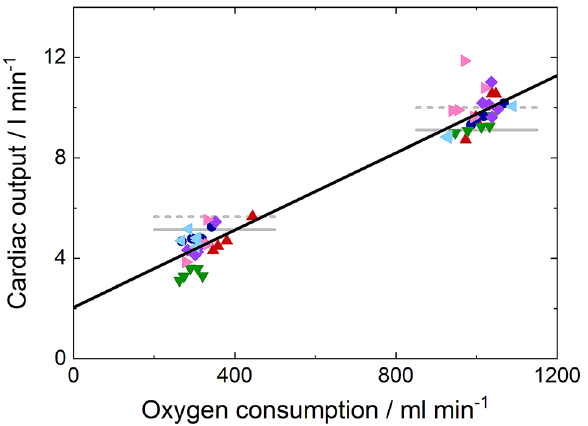
Figure 6. Fitted linear relationship between cardiac output and oxygen consumption. The linear fit to the measured cardiac output data is shown with a solid black line. Individual cardiac output measurements are shown with a different symbol and colour for each participant. Horizontal lines illustrate the predicted cardiac output values for the average measured oxygen consumptions at rest and during exercise from two studies using the direct Fick method. Data from Johnson et al . 12 are shown as full lines, and those from Bevegard et al . 13 as broken